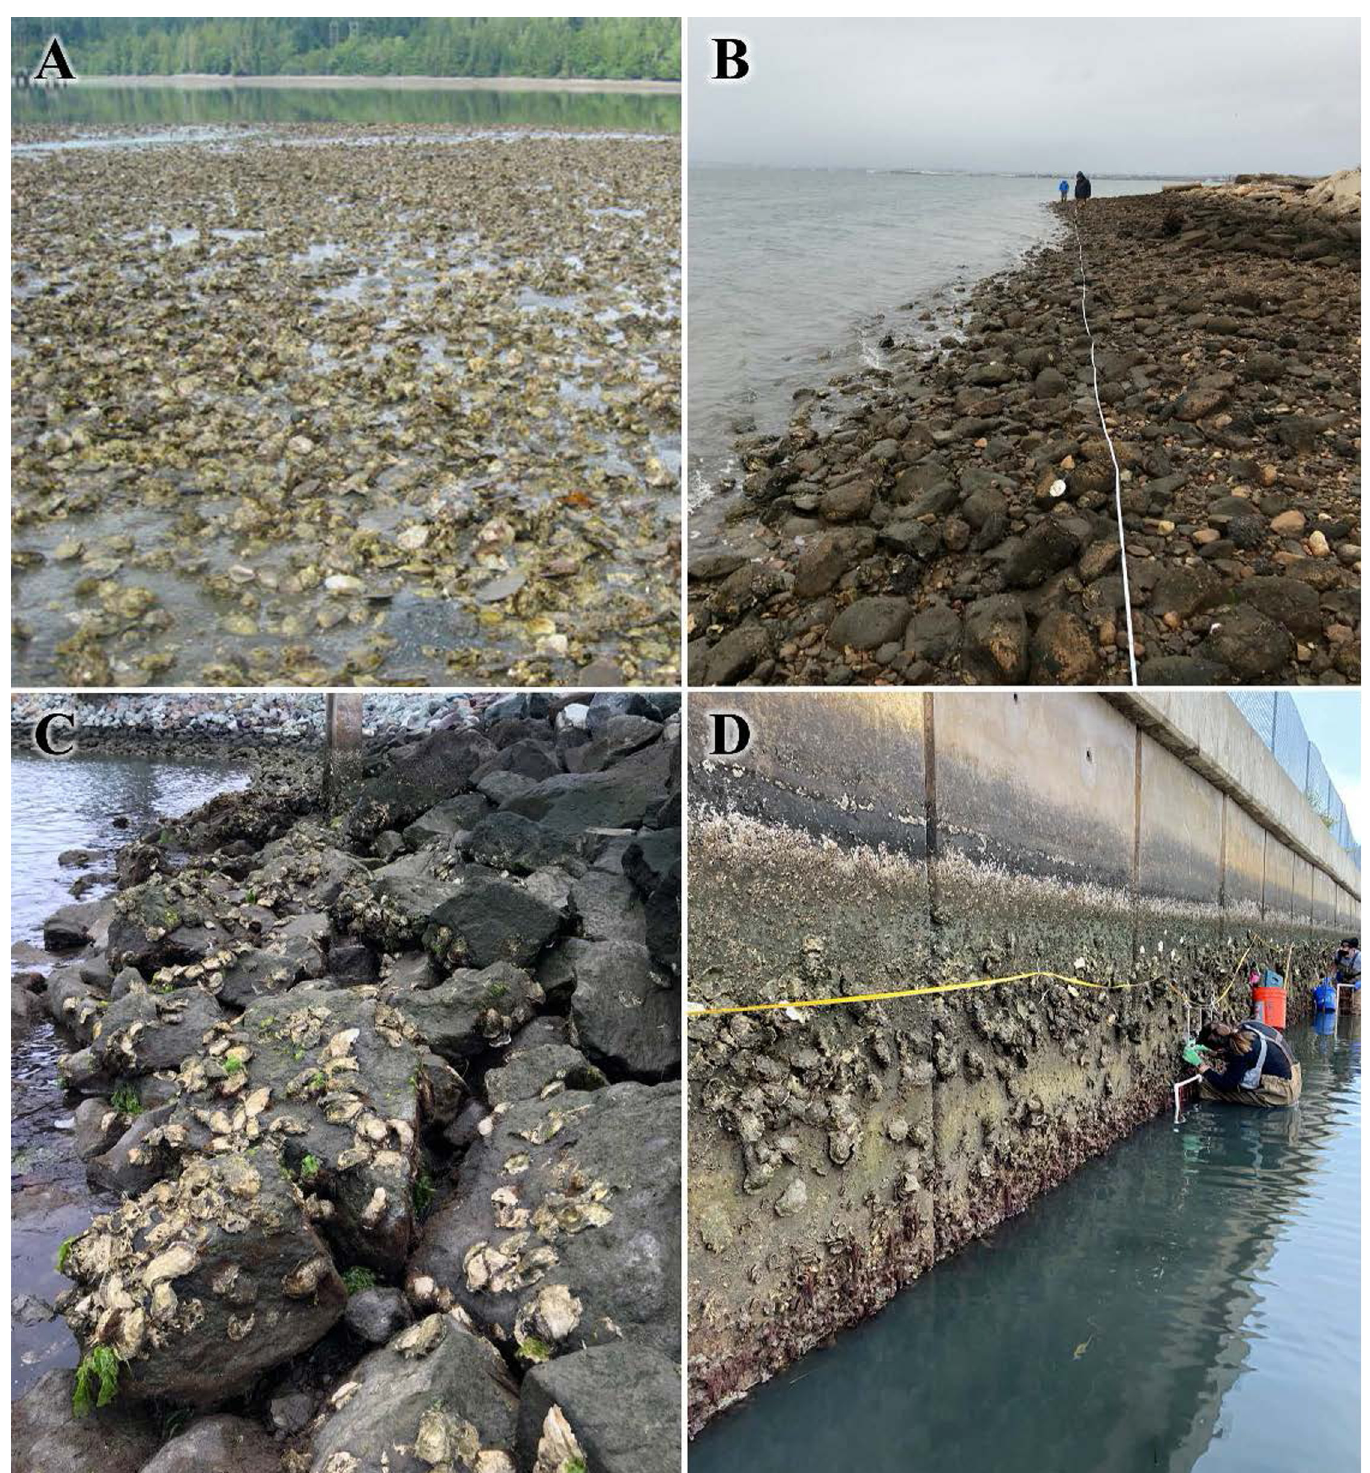
Fig 15. Examples of substrate types in survey. (A) O . lurida bed in North Bay, Case Inlet, Washington (Photo: B. Blake). (B) M . gigas on cobble at Chula Vista Wildlife Reserve, San Diego Bay, California (Photo: D. Zacherl). (C) M . gigas on riprap and pier piling in San Diego Bay, California (Photo: B. Perog). (D) M . gigas and O . lurida on seawall in San Diego Bay, California (Photo: D.